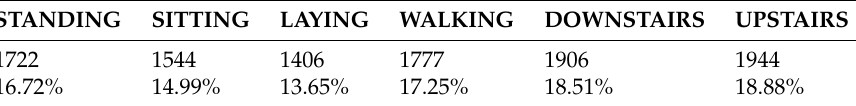
Table 5. Activity proportion of human activity recognition dataset of UCI.